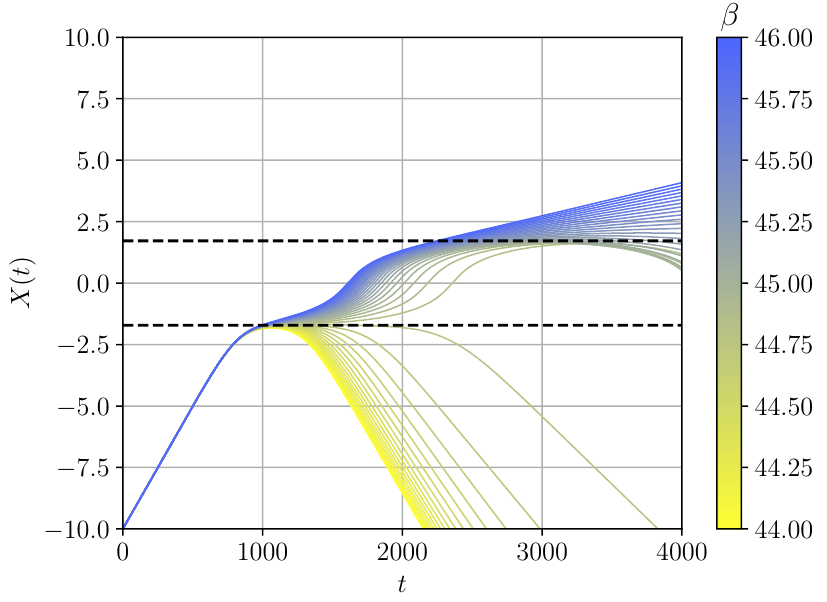
Figure 4 . Antikink’s position as a function of time for several values of the back-reaction coupling constant β